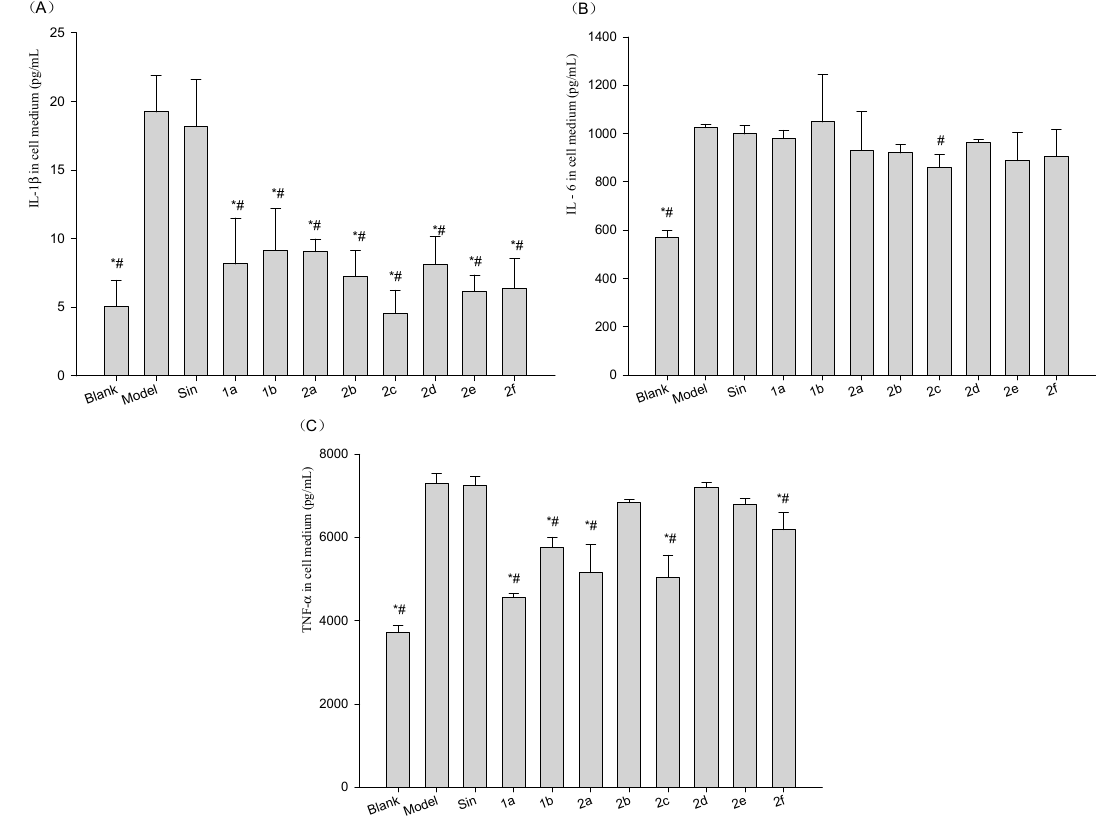
Figure 4. Effect of Sin or 1a – 2f on the extracellular secretion of ( A ) IL1 β ; ( B ) IL6, and ( C ) TNF- α in LPS-treated Raw264.7 cells. Raw264.7 cells were treated with 1 µ g/mL of LPS (Blank was untreated), followed by 10 µ g/mL Sin or 1a – 2f for a total of 12 h. The blank and vehicle (Model) samples were treated with an equivalent volume of arialhicle. Sin did not reduce the LPS-induced increase in IL1 β , IL6, or TNF- α , while the 1a – 2f derivatives had varying effects on these inflammatory cytokines. Results are expressed as mean ± SD ( n = 3). * p < 0.05 vs. vehicle (Model Group); # p < 0.05 vs. Sin Group.